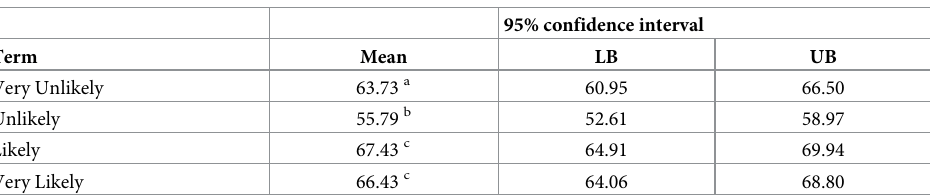
95% confidence interval